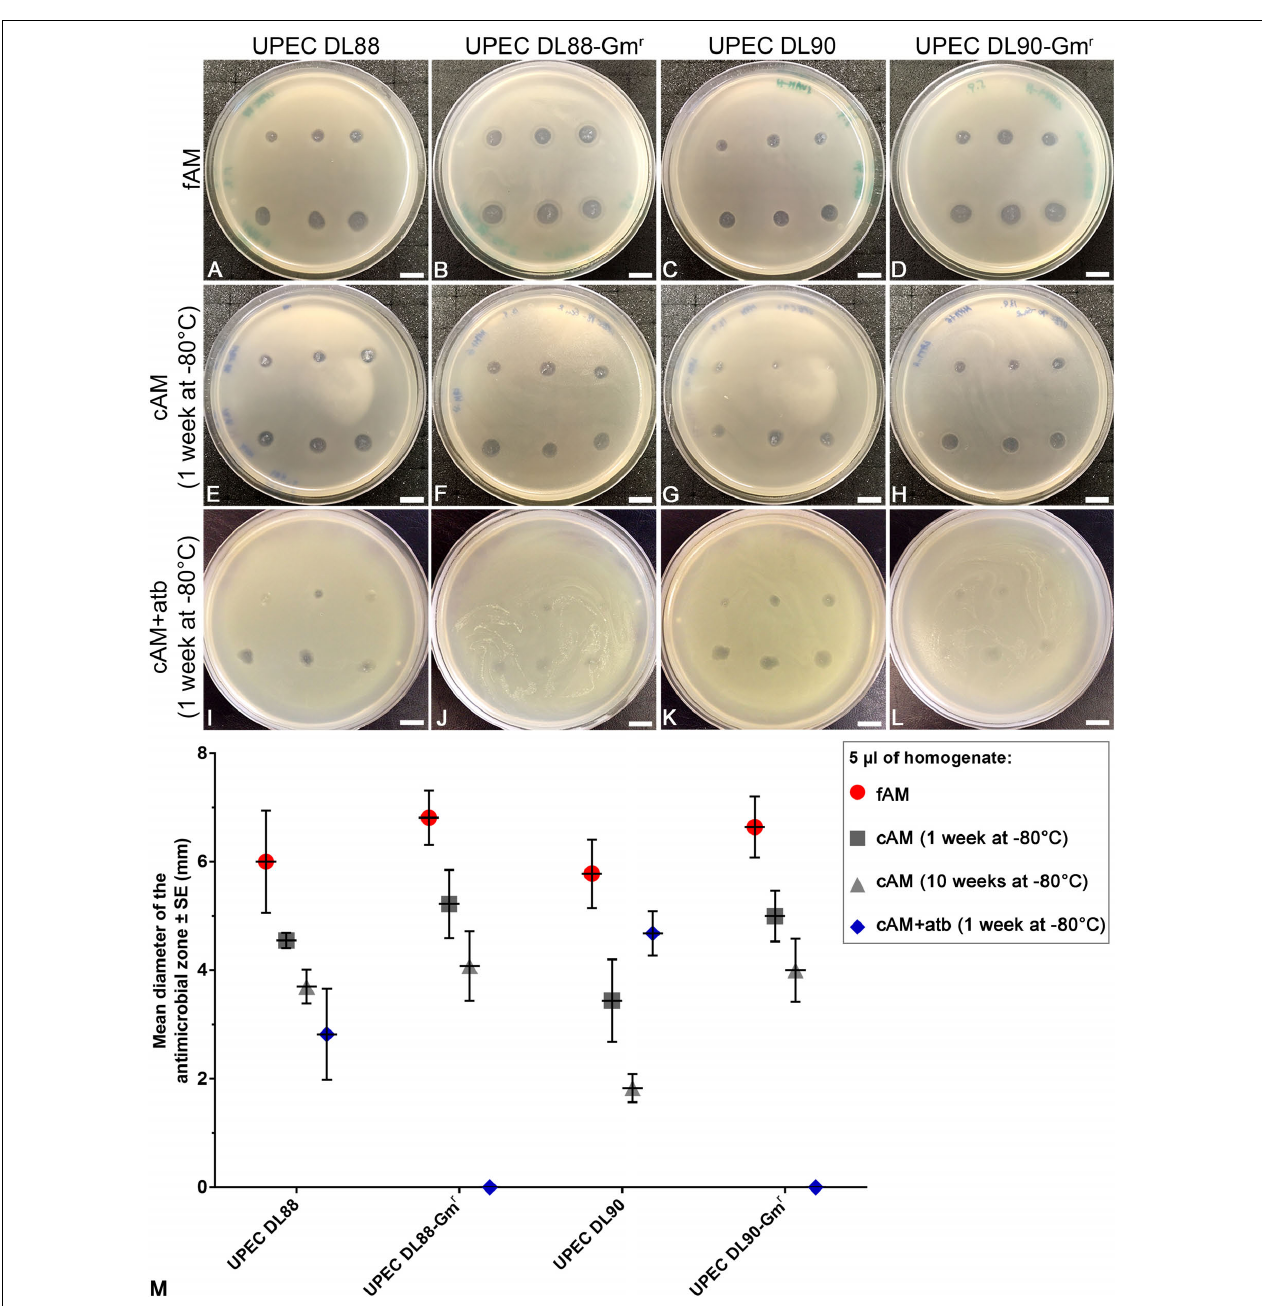
FIGURE 7 | Homogenates of fresh (fAM) and cAM (1 week at –80 ◦ C) have greater antimicrobial effect on UPEC strains and gentamicin-resistant UPEC strains than antibiotic-impregnated cAM + atb (1 week at –80 ◦ C) homogenate. (A–H) fAM and cAM (1 week at –80 ◦ C) homogenates have antimicrobial effect on UPEC DL88 and UPEC90 strains and gentamicin-resistant UPEC strains (UPEC DL88-Gm r , UPEC DL90-Gm r ). (I,K) cAM + atb (1 week at –80 ◦ C) homogenate has antimicrobial effect on UPEC DL88 and UPEC DL90 strains, but not on UPEC DL88-Gmr and UPEC DL90-Gmr strains (J–L) . Slight decrease in UPEC DL88-Gm r and UPEC DL90-Gm r growth might be attributed to residual intrinsic antimicrobial factors of AM that were not washed out of AM during preparation and storage. The quantity of fAM, cAM (1 week at –80 ◦ C) and cAM + atb (1 week at –80 ◦ C) homogenates used was 5 µ l (upper rows) and 10 µ l (lower rows). Scale bars: 10 mm. (M) Each point presents the mean diameter of the antimicrobial zone ± standard error (mm) when testing fAM/cAM (1 week at –80 ◦ C)/cAM (10 weeks at –80 ◦ C)/cAM + atb (1 week at –80 ◦ C) homogenates on UPEC and gentamicin-resistant UPEC strains. The quantity of AM homogenates used was 5 µ l. For fAM each point represents the mean diameter of the antimicrobial zone ± SE (mm) for three independent replications of experiments using three biological samples; each experiment was performed in nine technical repeats for each strain. For cAM (1 week at –80 ◦ C) each point represents the mean diameter of the antimicrobial zone ± SE (mm) for three independent replications of experiments using three biological samples; each experiment was performed in three technical repeats for each strain. For cAM (10 weeks at –80 ◦ C) each point represents the mean diameter of the antimicrobial zone ± SE (mm) for three independent replications of experiments using three biological samples; each experiment was performed in six to nine technical repeats for each